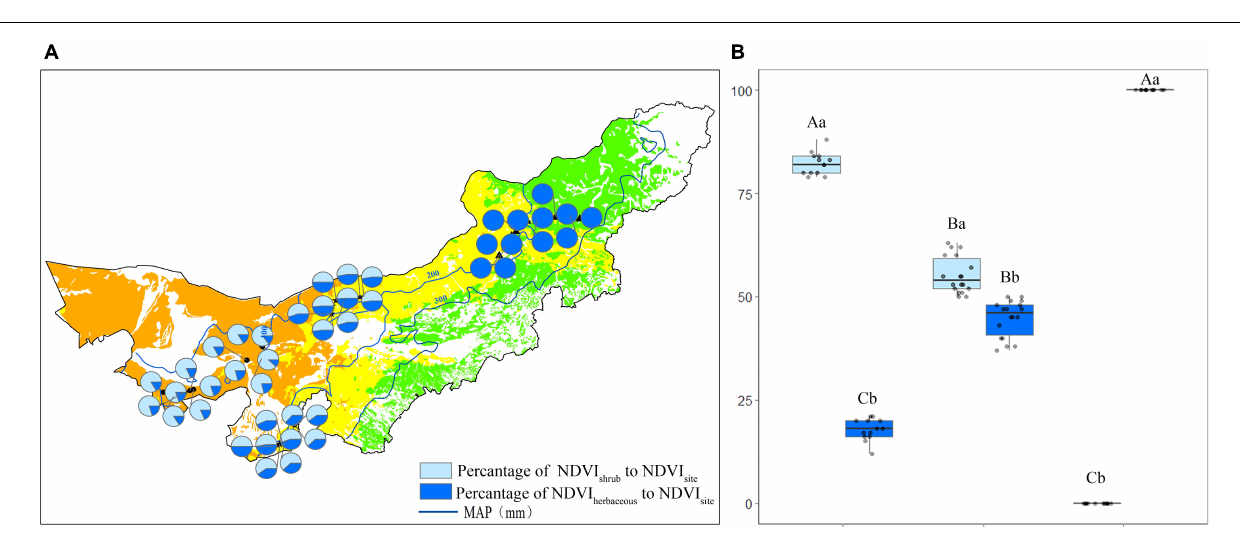
FIGURE 5 | The percentage (%) of shrub/herbaceous NDVI to the site NDVI in each observation site (A) , and statistics for desert, transition zone, typical steppe (B) in July. Different capital letters denoted significant differences of the percentage of shrub/herbaceous NDVI to the site NDVI among desert, transition zone and typical steppe ( P < 0.05); while different lowercase letters denoted significant differences between shrub and herbaceous ( P < 0.05); the same letters denoted non-significant differences ( P > 0.05); MAP represents the mean annual